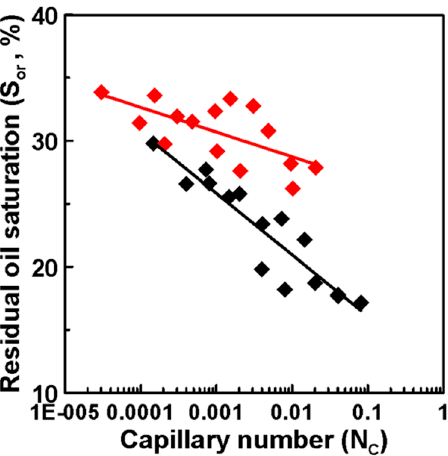
9 of 11 Figure 9. Oil recovery as a function of ( a ) flow rate and ( b ) oil viscosity in the presence or absence of a zwitterionic surfactant. ( c ) Emulsion stability as a function of oil viscosity in the presence or absence of a zwitterionic surfactant. To explore the effects of viscous and capillary forces on residual oil saturation, we calculated saturation by capillary number (cid:4666)(cid:1840) (cid:3030) (cid:4667) (Figure 10) using (cid:1840) (cid:3030) = (cid:3049)(cid:3091) (cid:3298) (cid:3097) (cid:3290)(cid:3298) , where (cid:1874) is the interstitial velocity, (cid:2020) (cid:3050) is the viscosity of the colloidal dispersion, and (cid:2026) (cid:3042)(cid:3050) is the interfacial tension between the oil phase and the dispersion. The capillary number depends on the injection rate and oil viscosity. As shown in Figure 10, residual oil saturation decreased with increasing capillary number. In general, capillary forces are negligible compared to viscous forces when the capillary number is higher than 10 − 5 ; oil